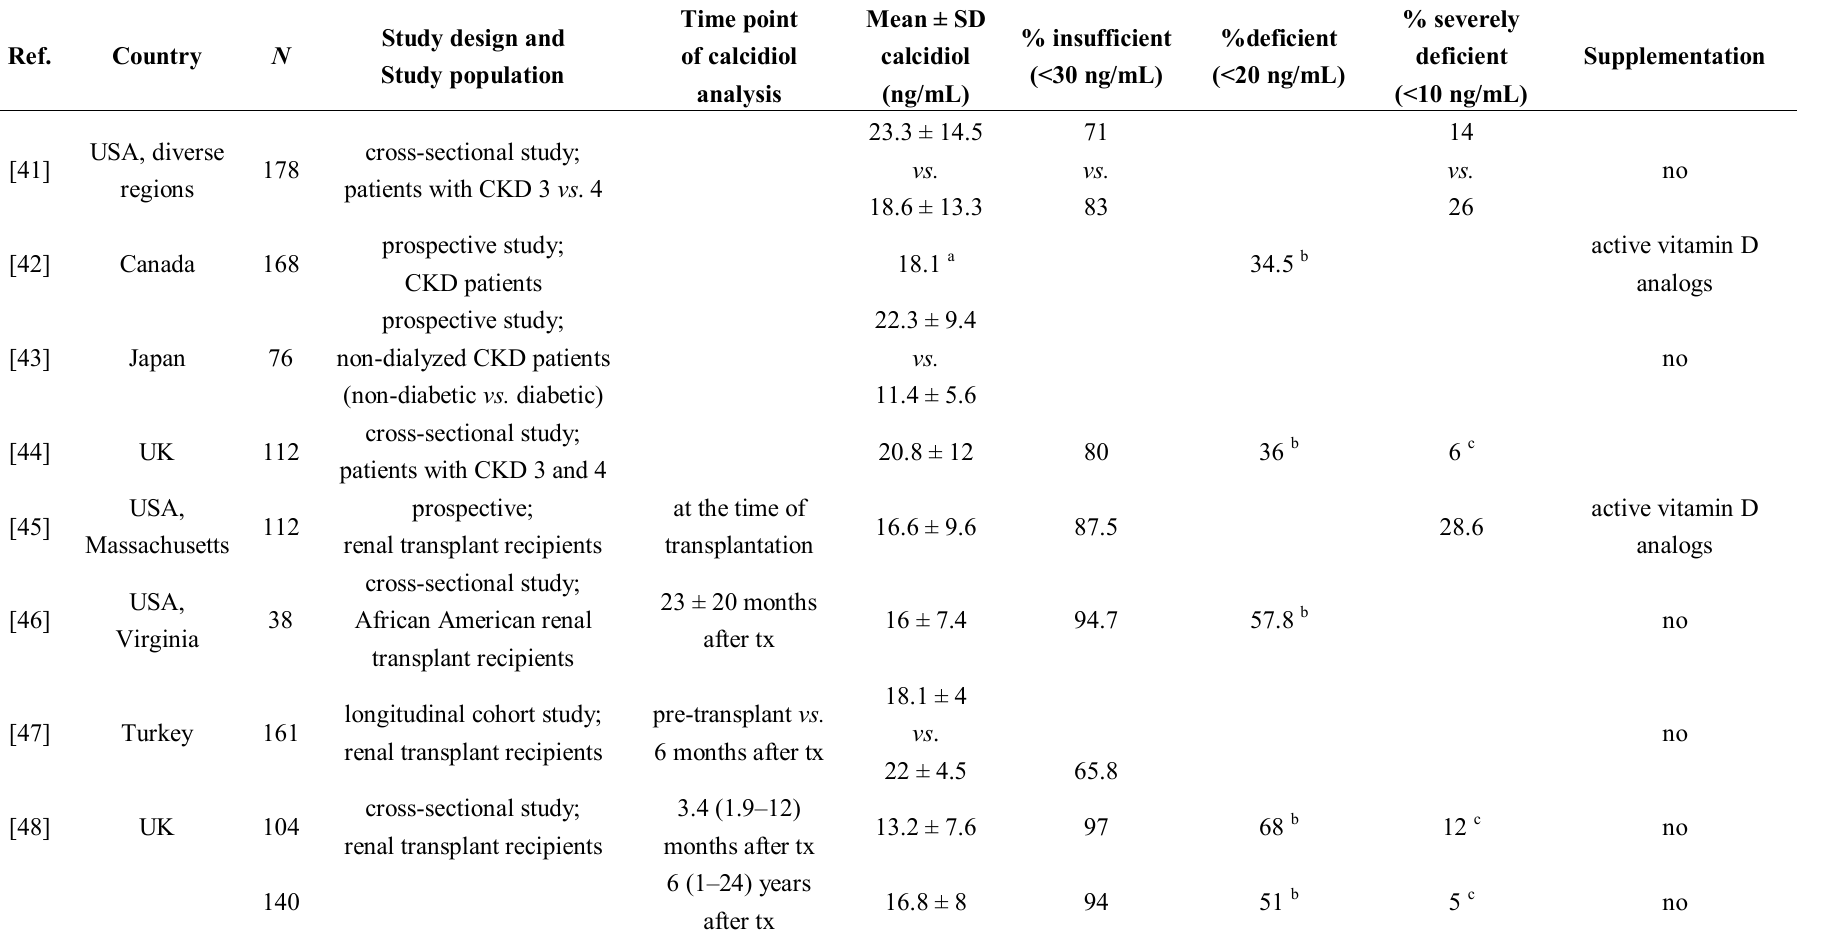
Table 4. Vitamin D status in chronic kidney disease and renal transplant